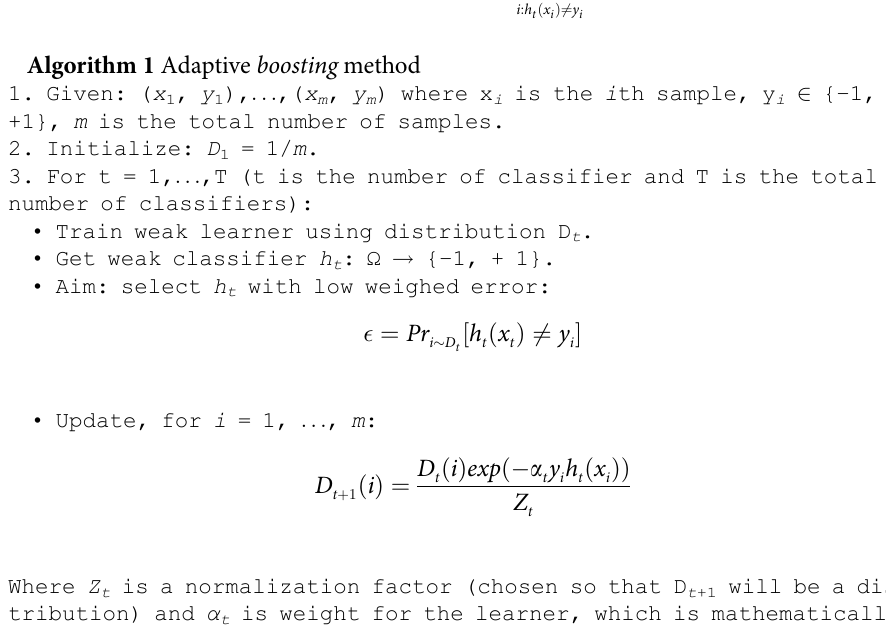
Algorithm 1 Adaptive boosting method